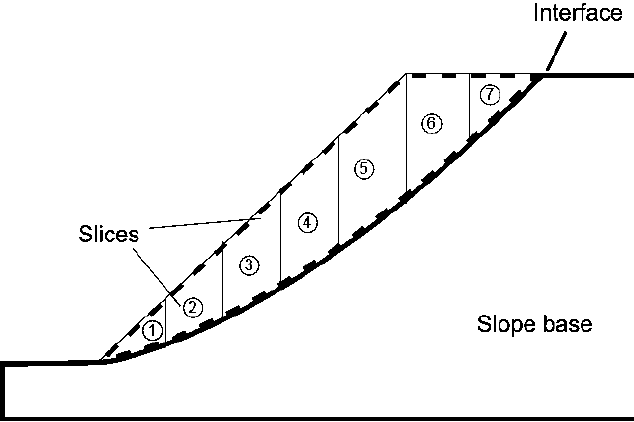
Fig. 3. Discretizing the slope in the method of